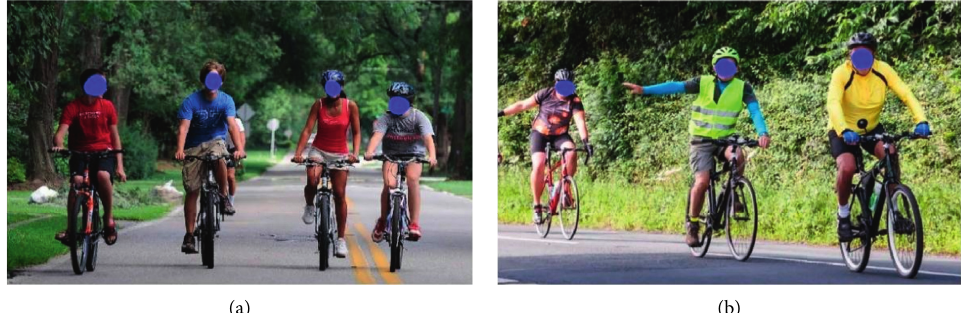
Figure 1: Bicycle’s two typical group behaviors. (a) Shoulder group behavior and (b) following group